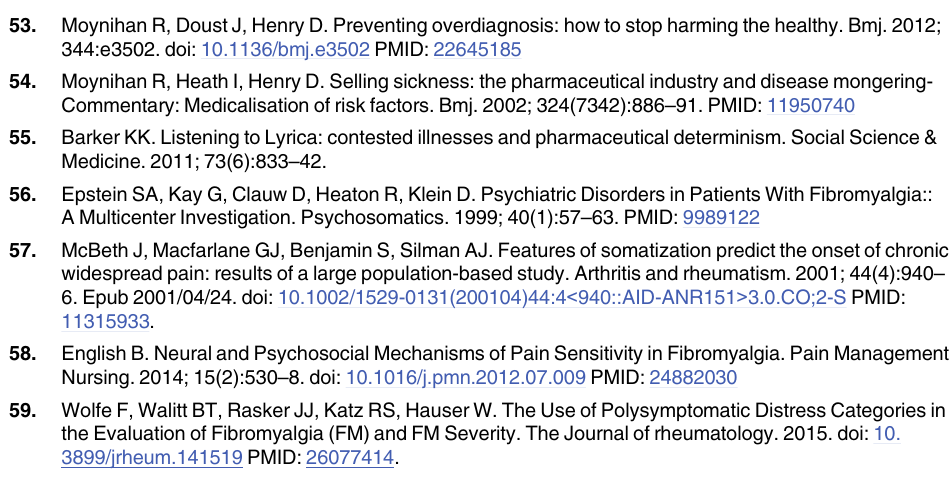
PLOS ONE | DOI:10.1371/journal.pone.0138024 September 17,